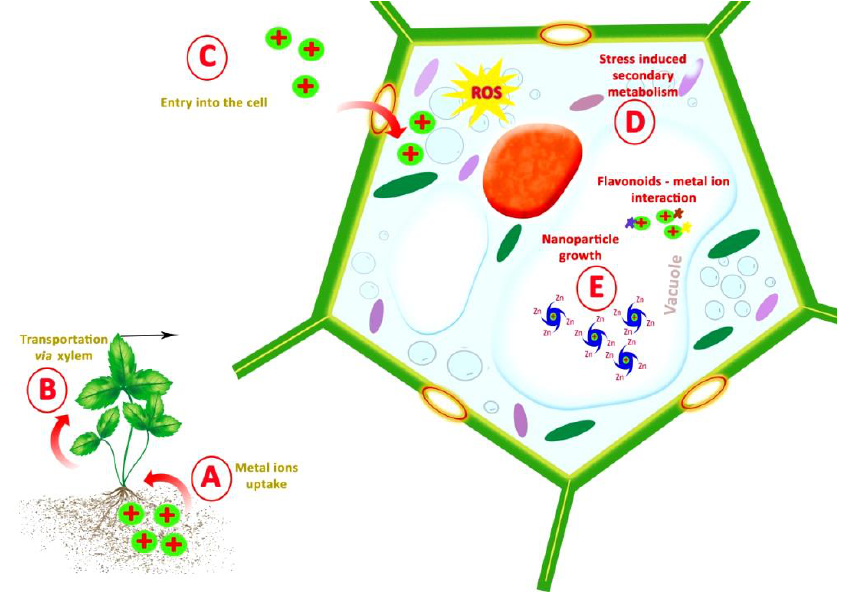
Figure 2. A scheme describing the possible mechanism of in vivo green synthesis of NPs.